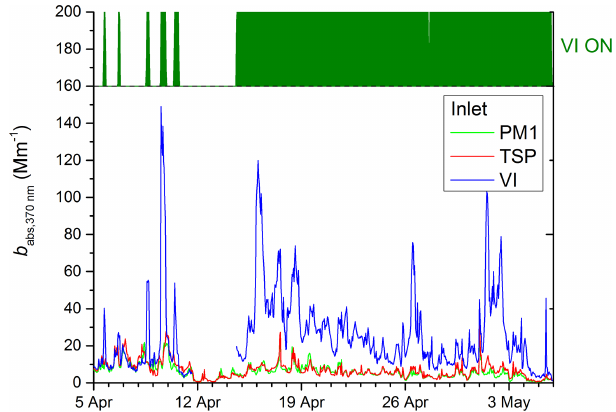
Figure 3. Time series of the aerosol absorption coefficient at 370nm for three Aethalometer instruments, AE33, running in parallel and equipped with different inlets: PM 1 , total suspended particle (TSP), and virtual impactor (VI). The periods when VI was operating are marked in green (VI